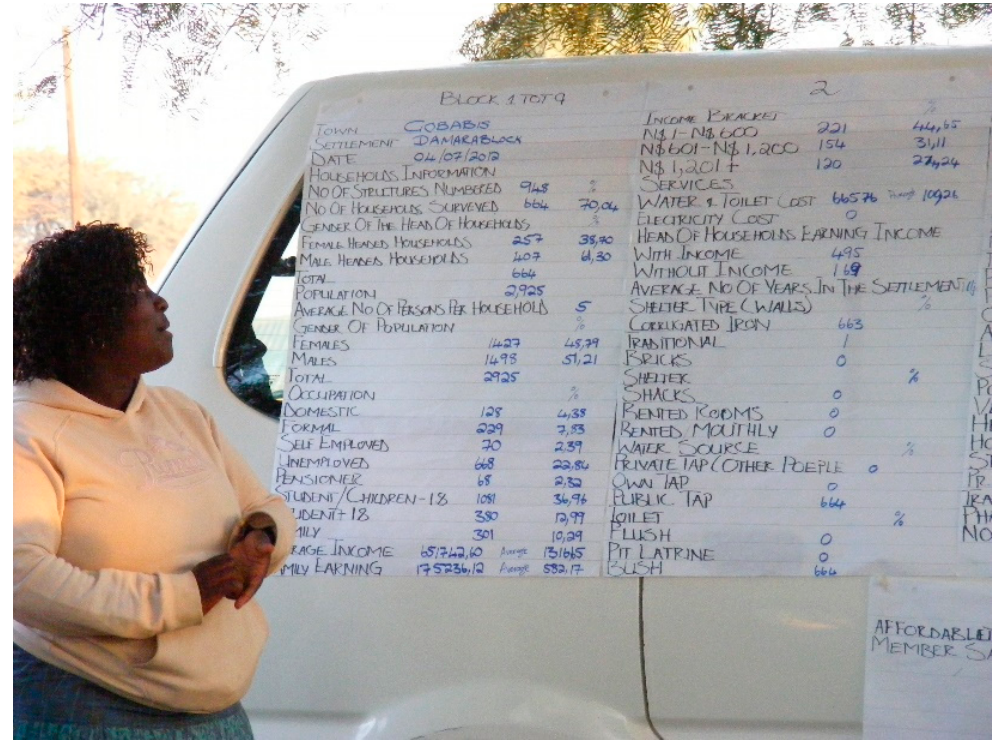
Figure 4. Community representative presenting data from enumerations (Source: Authors’).